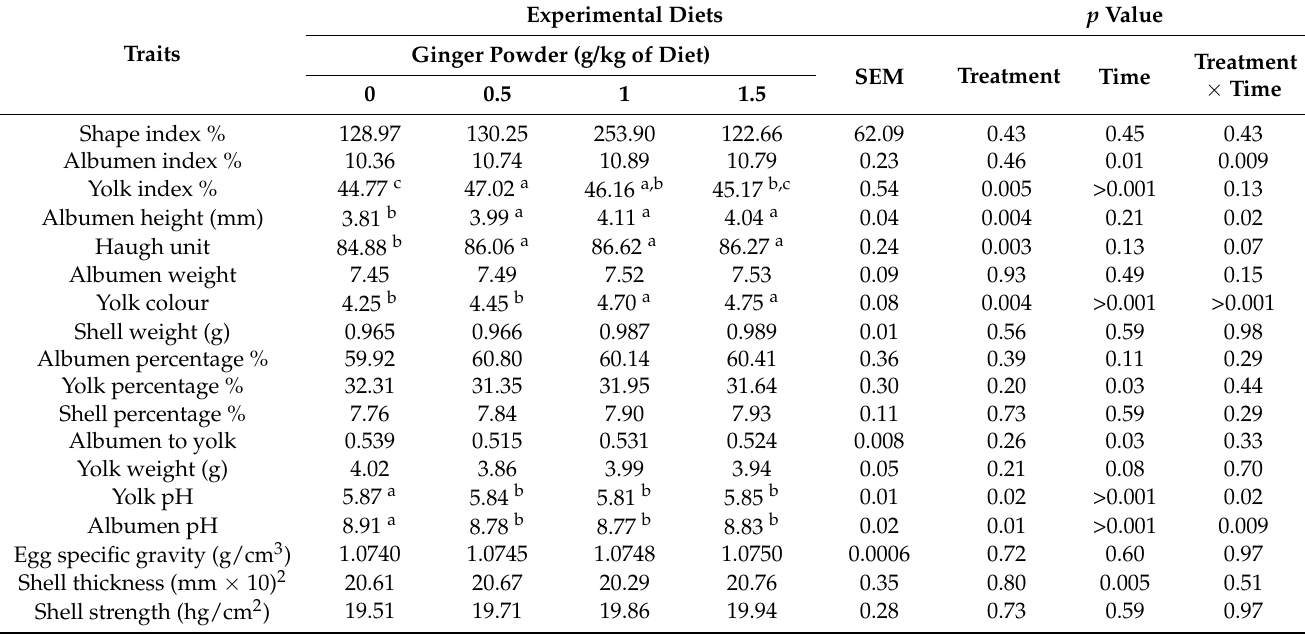
Table 4. Effect of different level of ginger root powder on egg quality of Japanese quails.